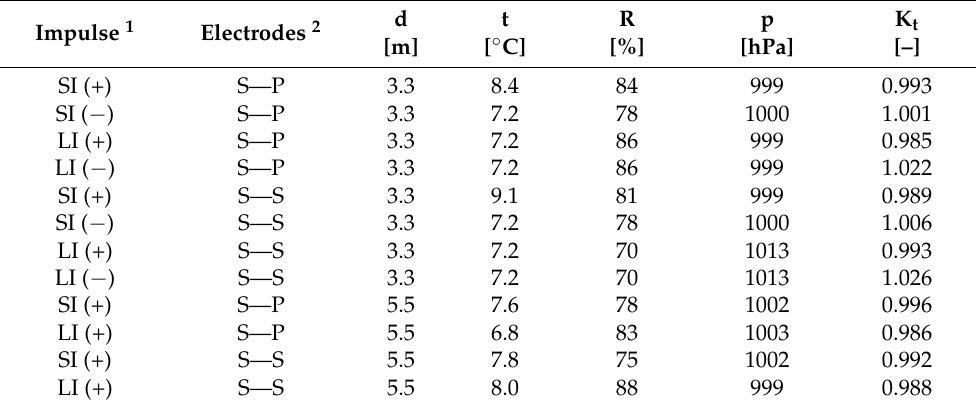
Table 1. Atmospheric conditions for high voltage tests: d—distance between electrodes, t— temperature, R—relative humidity, p—atmospheric pressure, Kt—atmospheric correction factor.